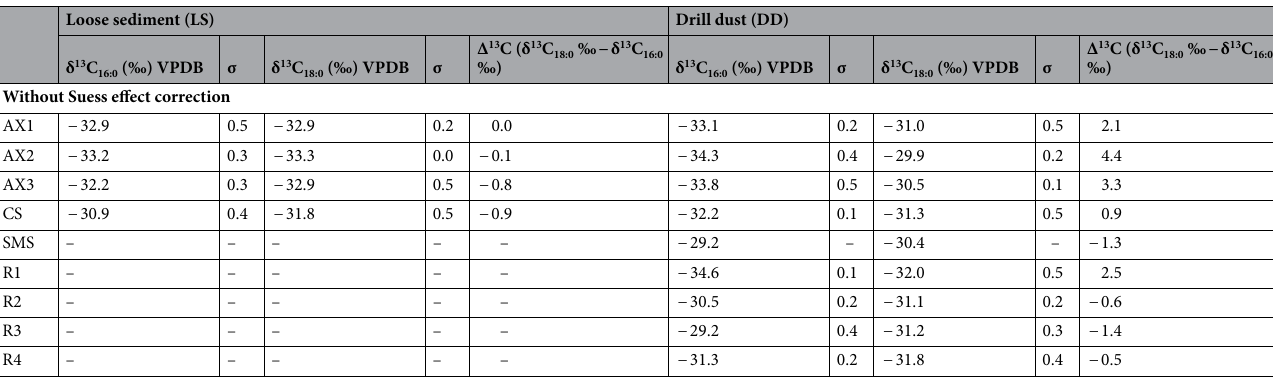
Table 1. C 16:0 and C 18:0 fatty acid δ 13 C values of calculated for LS and DD samples without Suess effect correction.